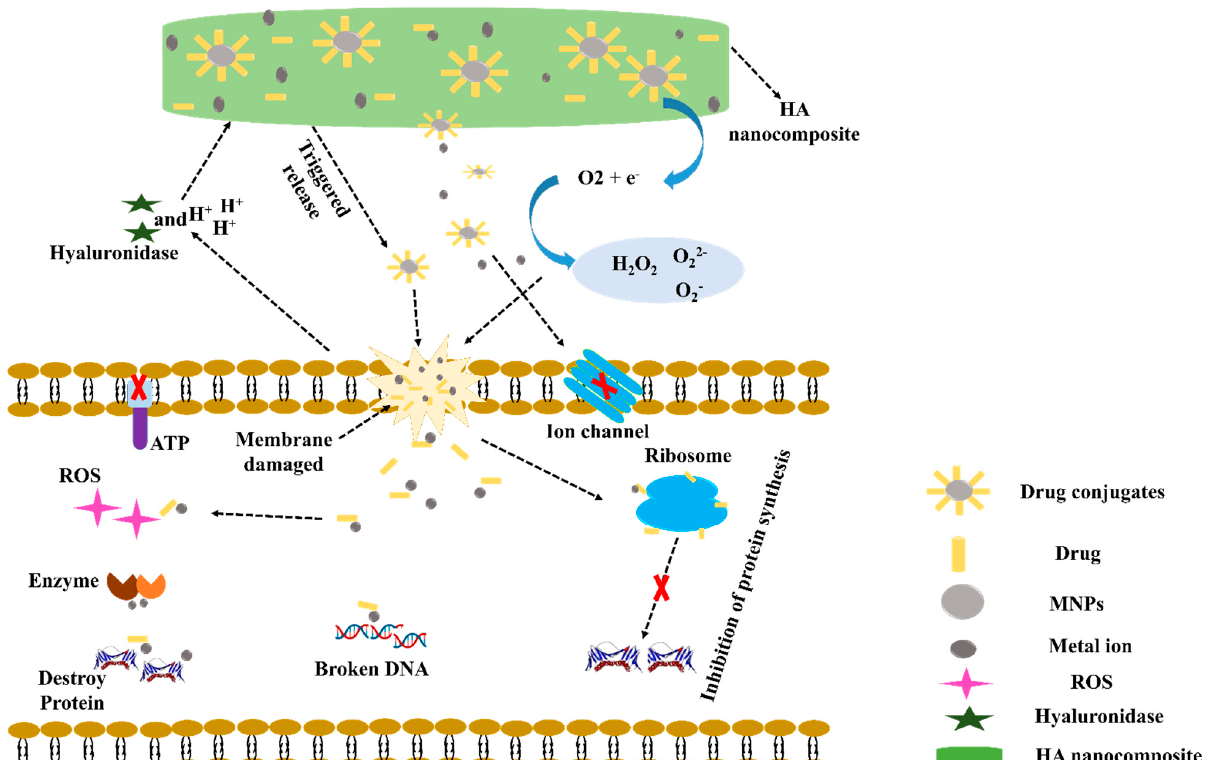
Figure 2. Possible antibacterial mechanism for a metal − based HA composite drug Copyright 2017, Elsevier [64].